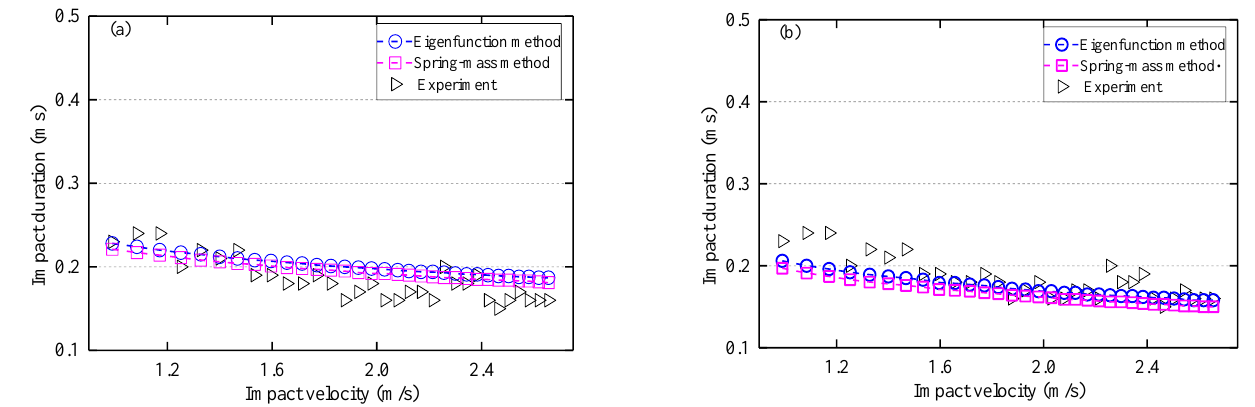
As shown in Figure 13a,b, the accumulated permanent indentation of the last impact for every impact velocity are analyzed. The accumulated permanent indentations pre- dicted by eigenfucntion expansion method and spring-mass method are compared with the experimental results. The plots show that the accumulated permanent indentation pre- dicted by eigenfucntion expansion method agree well with experimental results than spring-mass method. It means that the wave propagation has obvious influence on the accumulated permanent indentation of repeated impacts. Figure 13a,b shows that the ac- cumulated permanent indentation predicted by eigenfucntion expansion method is max- imally 44.46% and 69.97% less than those predicted by spring-mass method for UC model and MYC model, respectively. It means that by using different local contact models, large discrepancies can be obtained on simulating impact behaviors of eigenfunction expansion method. This demonstrates the importance of selecting appropriate local contact models. Figure 13. Comparison of the accumulated permanent indentation: ( a ) UC model; ( b ) MYC model.